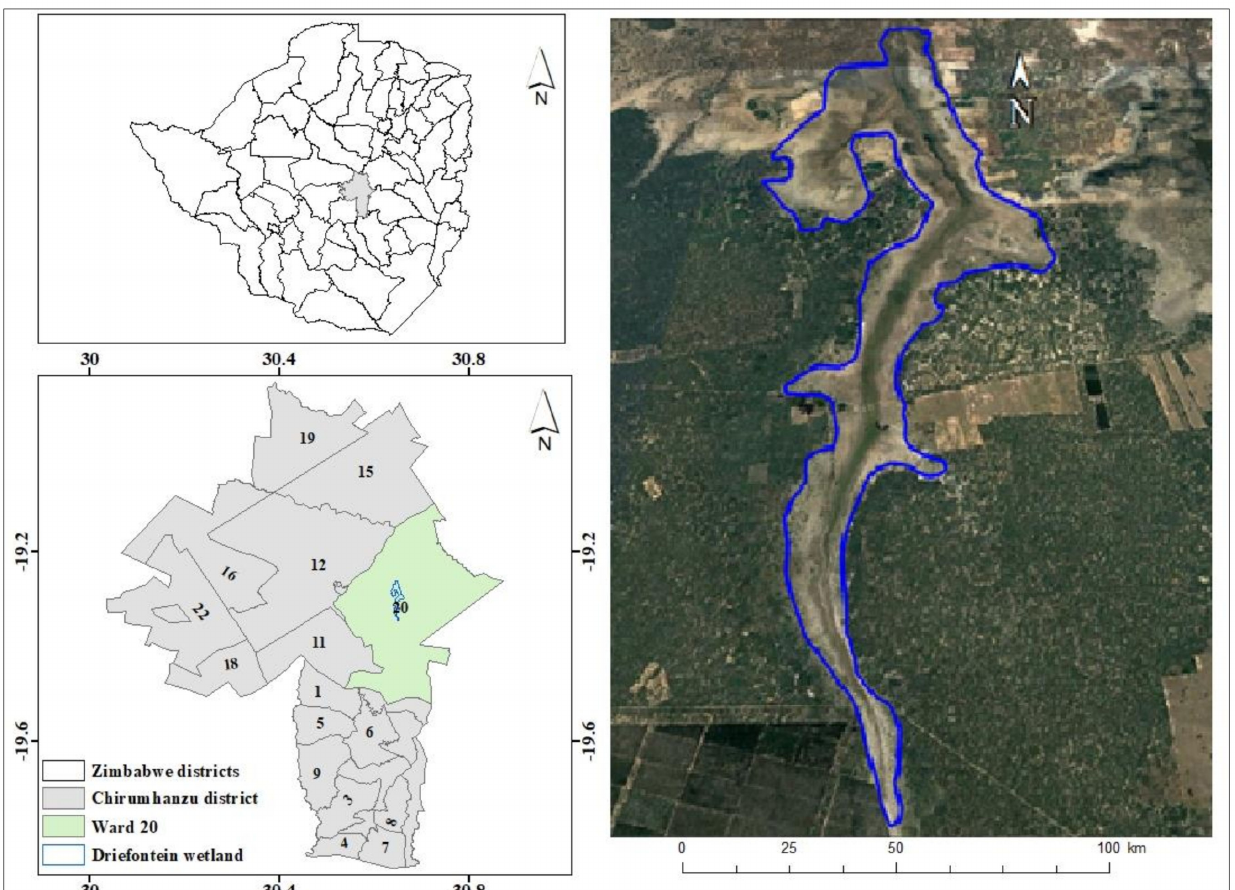
Figure 1. Driefontein wetland,